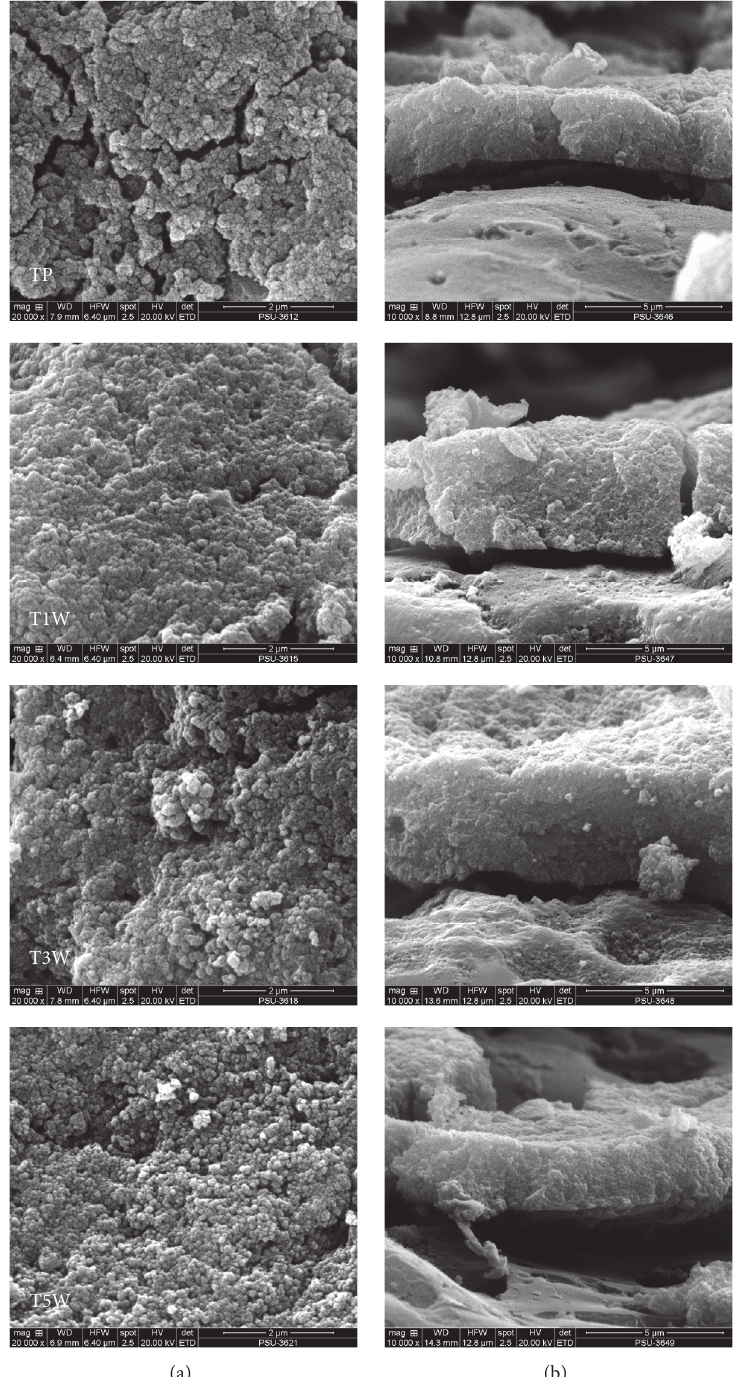
Figure 3: WO 3 -doped TiO 2 coated CA: (a) WO 3 -doped TiO 2 particulates adhered onto CA surface; (b) cross-sectional morphologies.